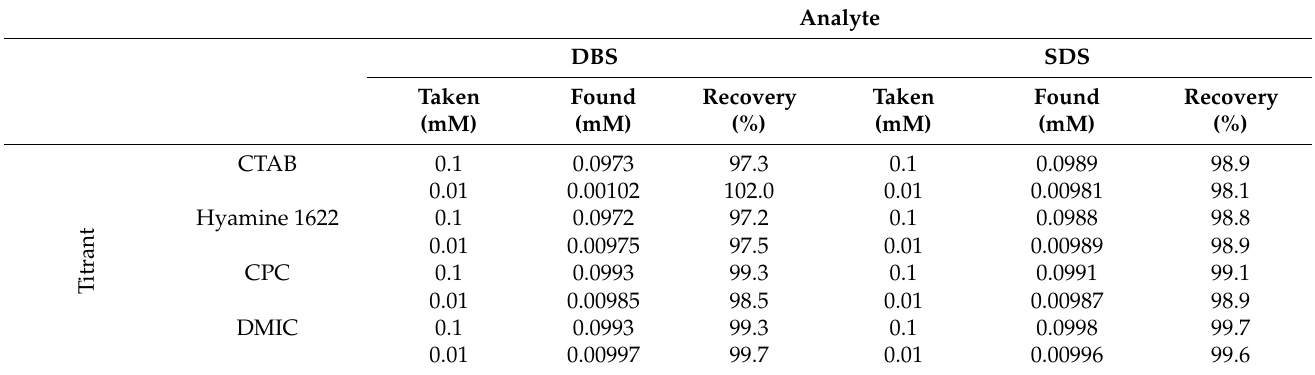
Table 4. Potentiometric titration results of SDS and DBS anionic surfactants with selected cationic